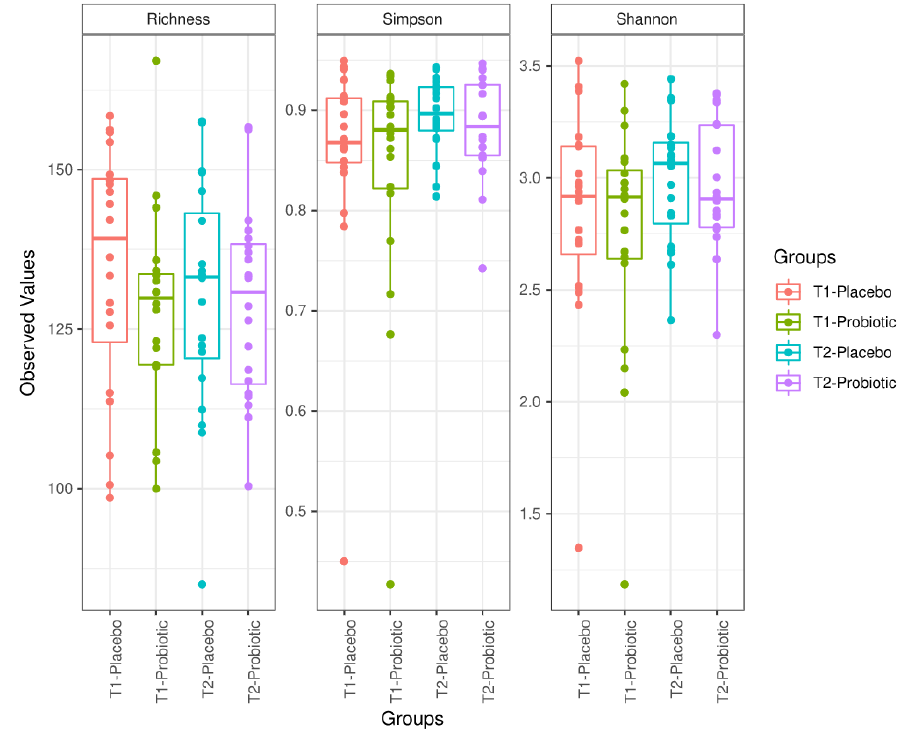
Figure 3. Richness, Simpson diversity index, and Shannon diversity index (from left to right ) in the placebo and probiotic group at baseline (T1) and at 6 weeks (end of study) (T2).